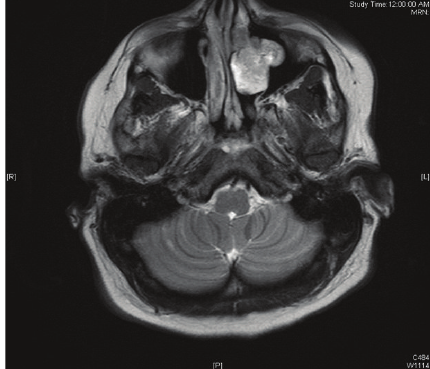
Figure 3: Low power view showing a nested proliferation of small hyperchromatic cells, prominent fibrillary background, focal microcalcification, and overlying respiratory